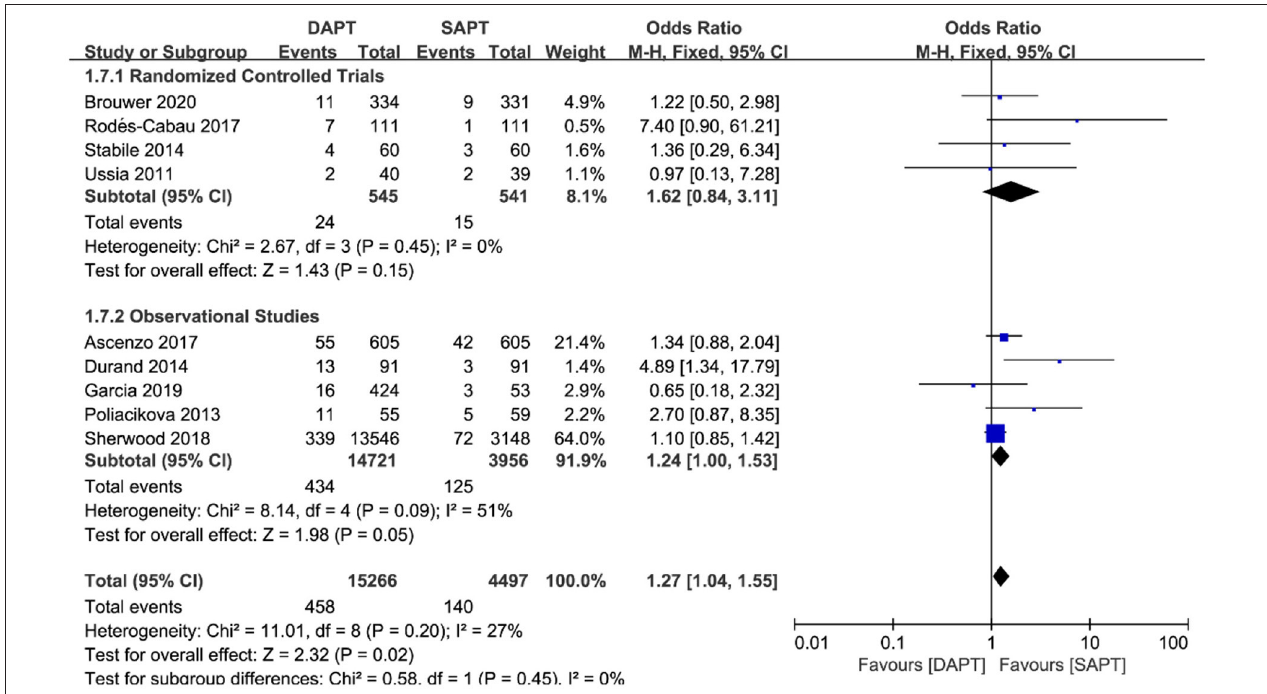
FIGURE 10 | Forest plot for life-threatening bleeding (LTB) with subgroup analysis stratified by study type at longest